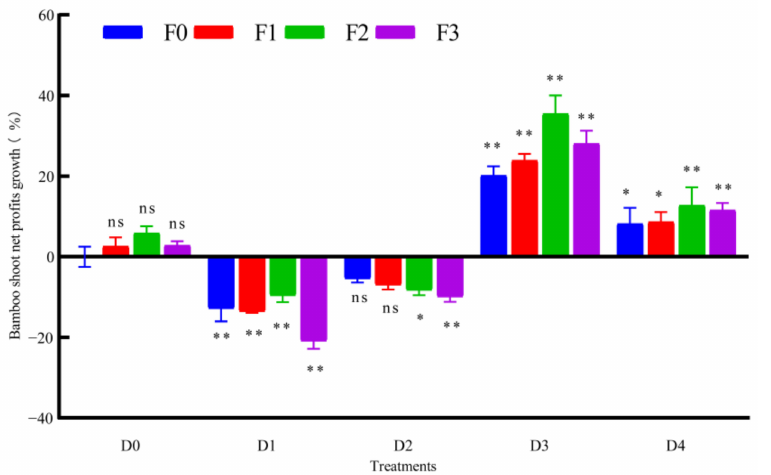
Figure 3. The bamboo-shoot net-profits-growth indexes of C. pachystachys forests by treatments. Error bars indicate standard error ( n = 3). * and ** show significance at the 0.05 and 0.01 levels according to Bonferroni’s test,